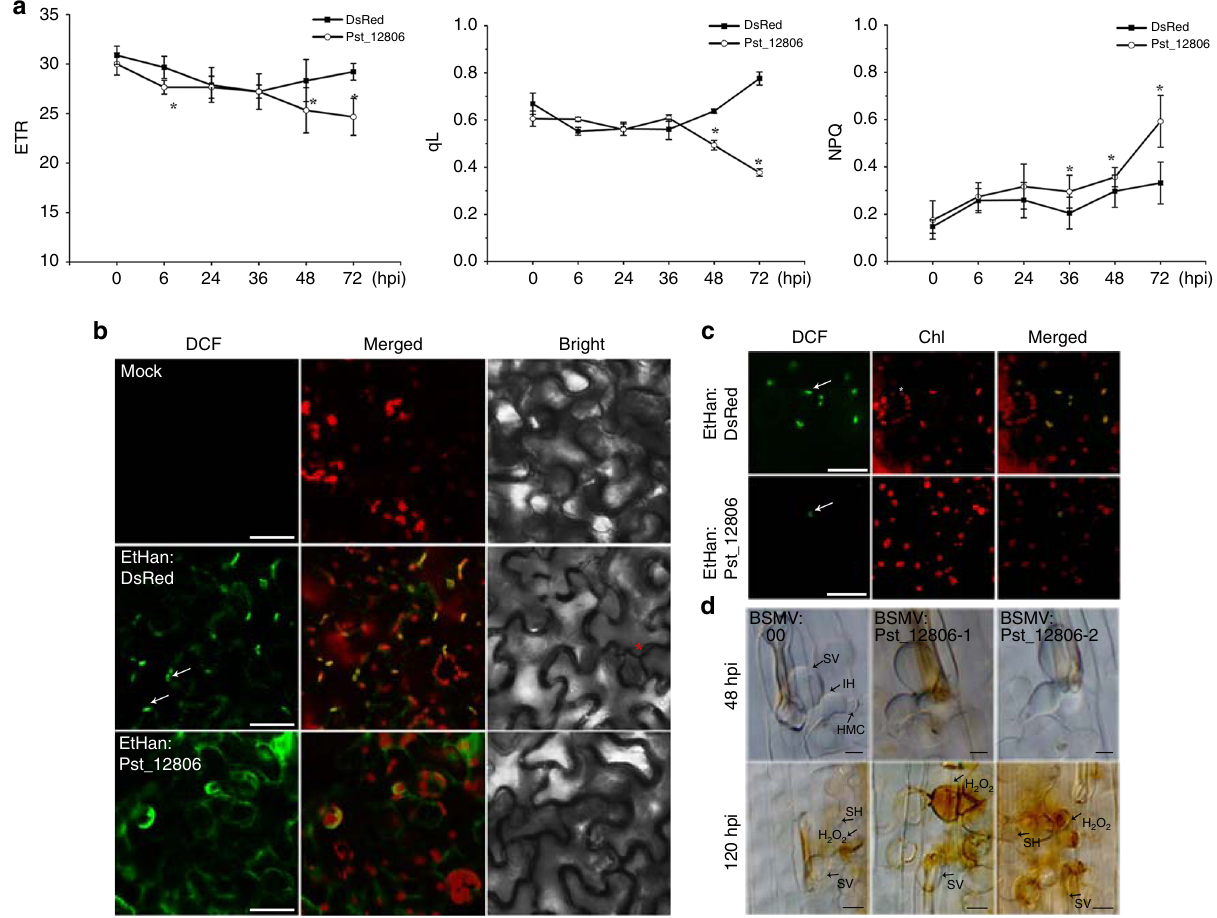
Fig. 7 Pst_12806 suppresses photosynthesis and chloroplast-derived ROS. a Assays for the values of electron transport rate (ETR), photochemical quenching (qL) and nonphotochemical quenching (NPQ) in N. benthamiana leaves in fi ltrated with Agrobacterium expressing Pst_12806 or DsRed (as the control). The mean and standard deviation of ETR, qL, and NPQ were calculated with data from six independent replicates. The asterisk indicates a signi fi cant difference ( P < 0.05, unpaired two-tailed Student ’ s t test). b N . benthamiana leaves treated with H 2 DCF-DA were observed by fl uorescence microscopy for DCF signals at 30 – 36 hpi after in fi ltration with bacteria expressing Pst_12806 or DsRed (control) or a mock solution. These arrows mark DCF signals in chloroplasts and asterisks mark guard cell, Bar = 50 μ m. c ROS accumulation in chloroplasts was reduced in leaves transiently